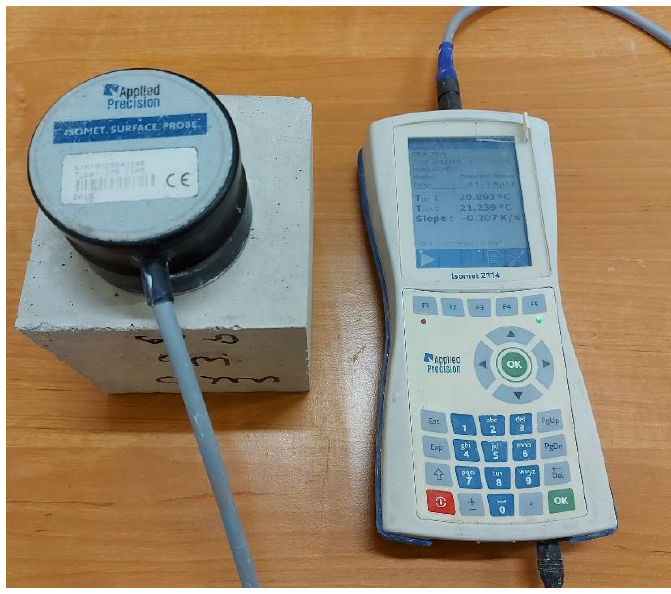
Figure 3. Investigations of the thermal properties of the modified building samples.